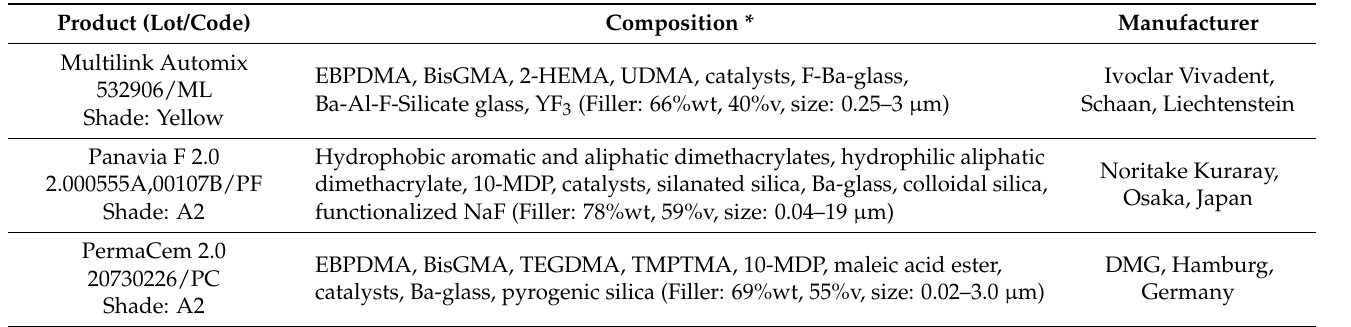
Table 1. The resin composite luting agents used in the